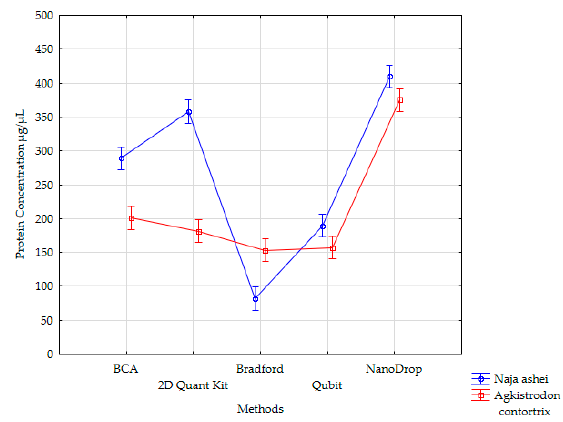
Figure 1. Method means for two-way main effects analysis of variance (Vertical bars denote 0.95 confidence intervals).